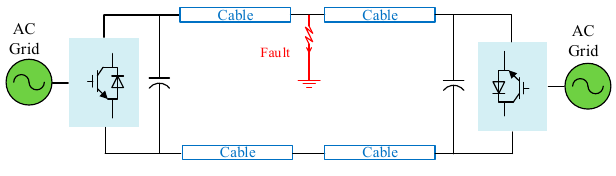
Figure 5. A two-port DC microgrid. The parameters and cable lengths of each element are shown in Table 1. A DC cable and bipolar connections were used. Table 1. DC microgrid model